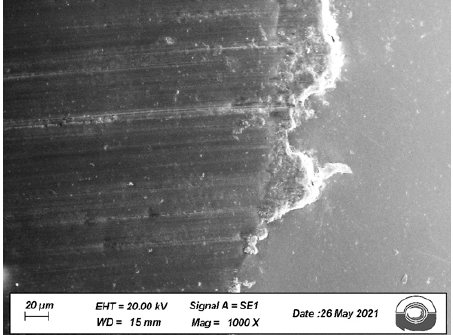
Figure 12. Detail of the edge of wear scar on ball after testing (Test 4).